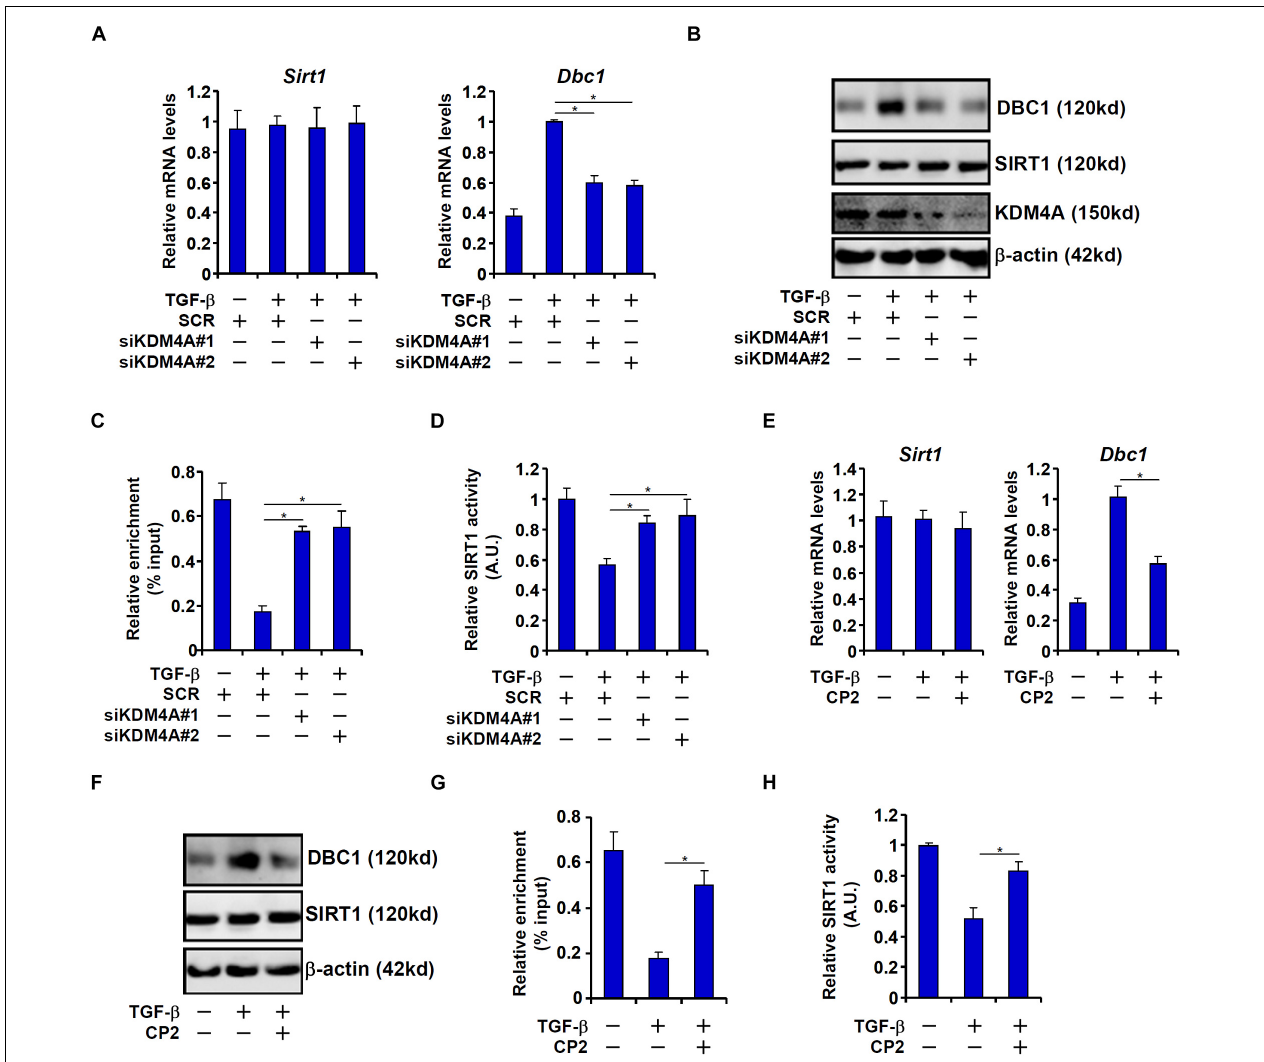
FIGURE 5 | KDM4A mediates TGF- β induced DBC1 transcription. (A–D) IEC-6 cells were transfected with siRNAs targeting KDM4A or scrambled siRNAs followed by treatment with TGF- β (2 ng/ml). DBC1 expression levels were examined by qPCR and Western. ChIP assay was performed with anti-trimethyl H3K9. SIRT1 activity was determined by a colorimetric kit. (E–H) IEC-6 cells were treated with TGF- β (2 ng/ml) in the presence or absence of CP2 (1 µ M). DBC1 expression levels were examined by qPCR and Western. ChIP assay was performed with anti-trimethyl H3K9. SIRT1 activity was determined by a colorimetric kit. All experiments were performed in triplicate wells and repeated three times. One representative experiment is